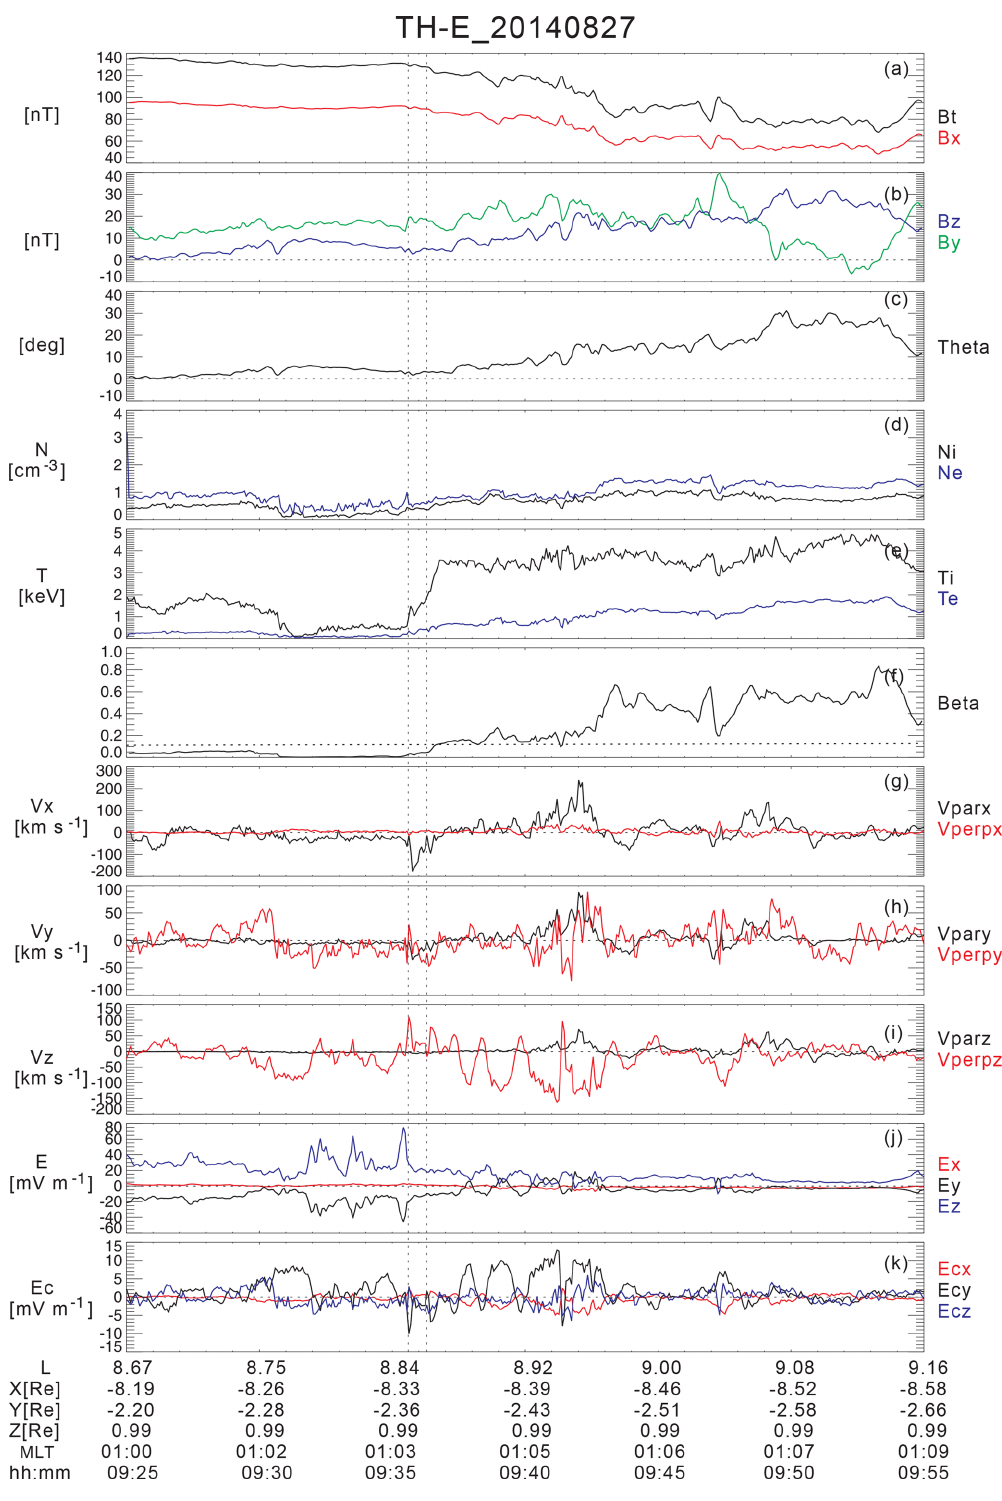
Figure 4. The electromagnetic field and plasma parameters detected by TH-E in intervals from 09:25 to 09:55UT on 27 August 2014. The figure format is the same as Fig. 3. The black vertical dashed lines mark the times 09:35:36 and